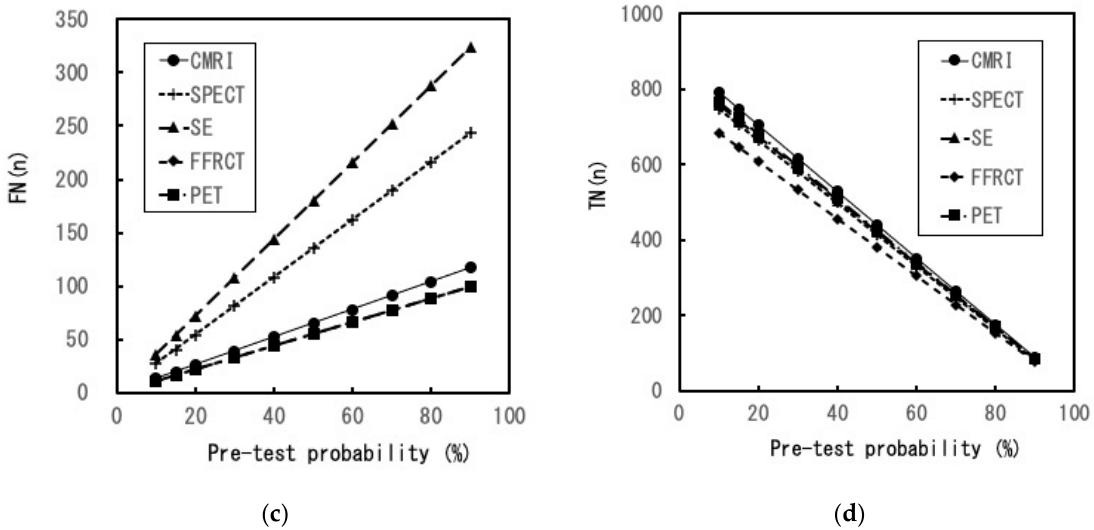
Figure 2. Sensitivity analysis (1). ( a ) Changes in the number of TP results with various pre-test probabilities of CAD. The number of TP PET and FFRCT results is equivalent; ( b ) changes in the number of FP results with various pre-test probabilities of CAD; ( c ) changes in the number of FN results with various pre-test probabilities of CAD. The number of FN PET and FFRCT results is equivalent; ( d ) changes in the number of TN results with various pre-test probabilities of CAD. CMRI: cardiac magnetic resonance imaging, SPECT: single-photon emission computed tomography, SE: stress echocardiography, FFRCT: fractional flow reserve derived from coronary computed tomography angiography, PET: positron emission computed tomography, TP: true positive, FP: false positive, FN: false negative, TN: true negative, CAD: coronary artery disease.